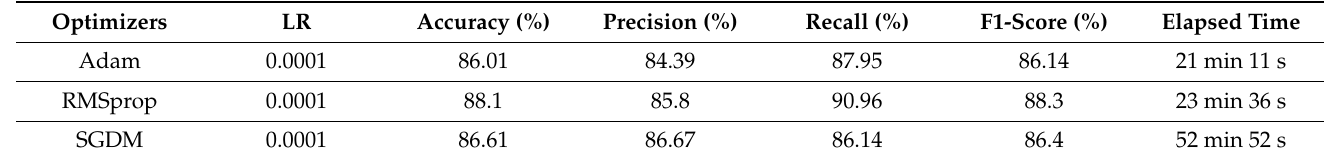
Table 6. Classification results of the proposed method using 3 s segments.